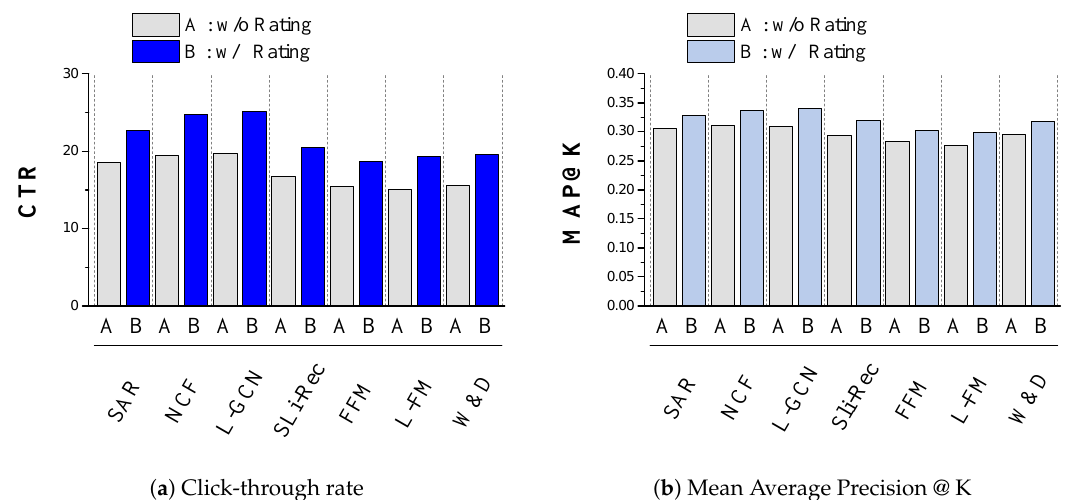
Figure 10. Visualization of A/B experiments for evaluative information ( Tweetings dataset).